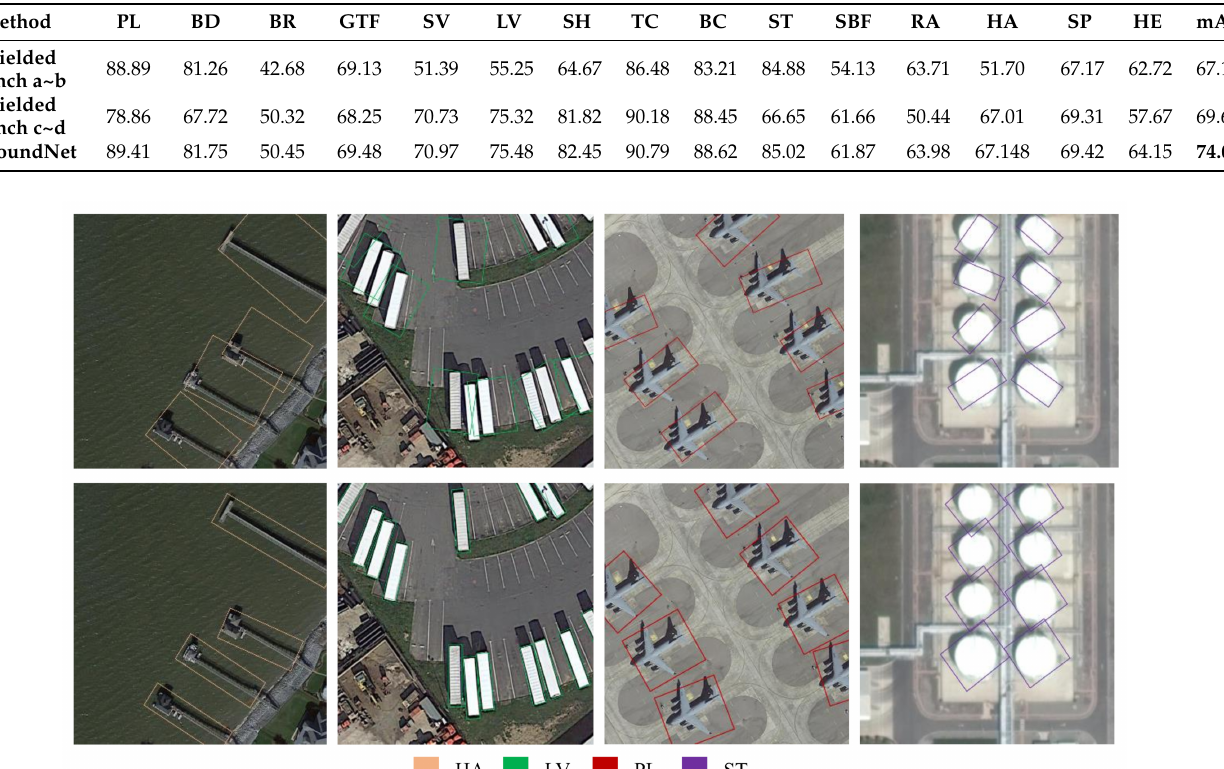
Table 5. The experimental results of shielding different regression branches.